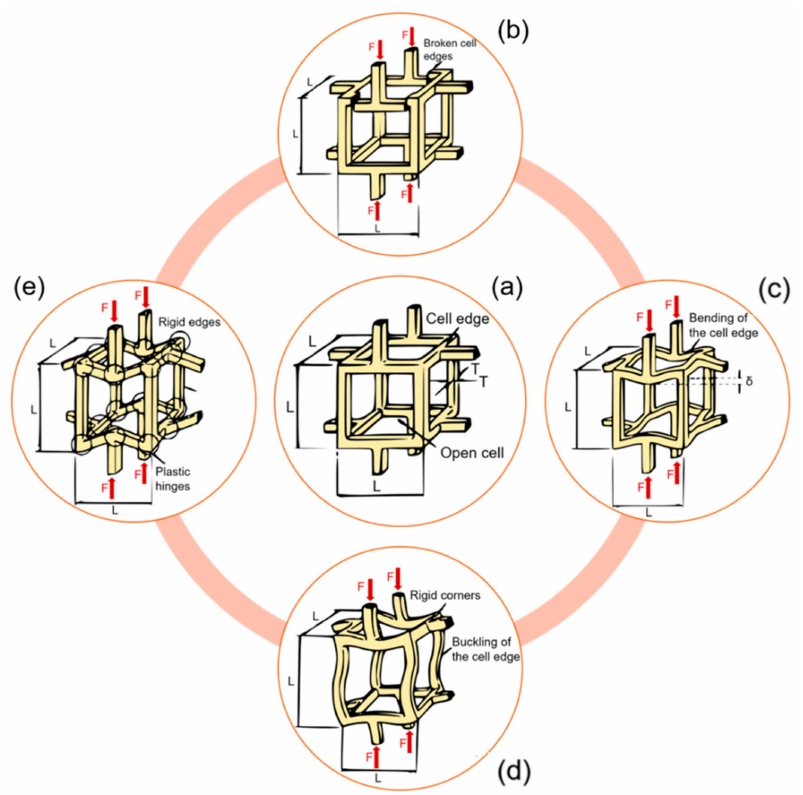
Figure 5. Different meso-scale failure modes of a trabecular network. ( a ) An unloaded trabecular cell. ( b ) Brittle crushing. ( c ) Bending of horizontal rods, compression of vertical rods. ( d ) Buckling of vertical rods, bending of horizontal rods. ( e ) Plastic yielding. Readapted from